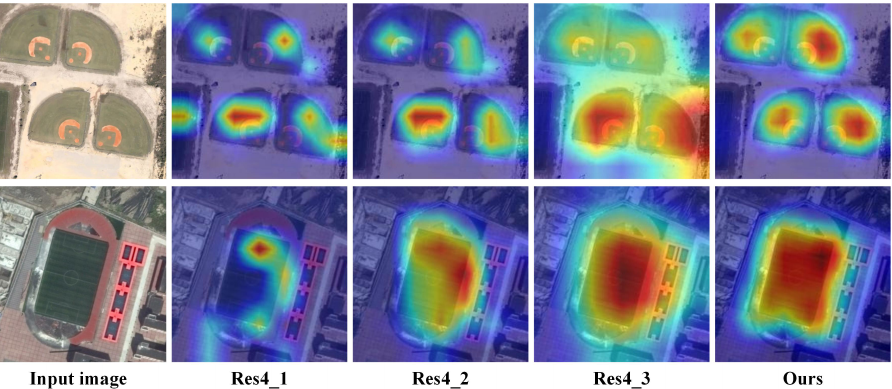
Figure 3. Grad-CAM visualization results. We compare the visualization results of our proposed channel–spatial attention with three other high-level convolutional feature maps of the last residual block of